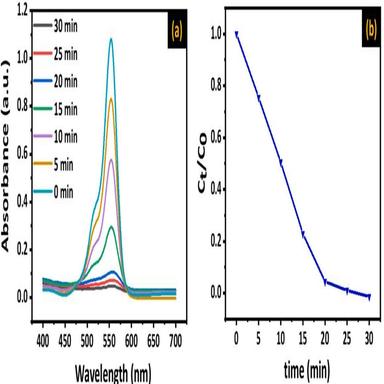
(a) Variation of the characteristic band of RhB as a function of degradation time, (b) kinetics of RhB degradation by BHP@ZnO.